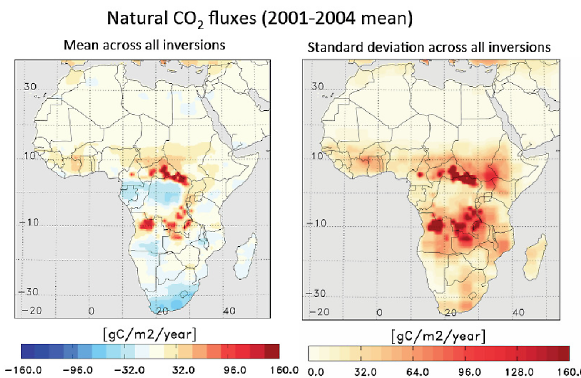
Fig. 3. (a) Distribution of mean CO 2 fluxes averaged across the five recent inversions analysed. (b) shows the spread of the inversions (defined from the estimator of the standard deviation). Inversions have a different spatial resolution, and the fluxes have been inter- polated on a common grid. Negative values are atmospheric CO 2 sinks